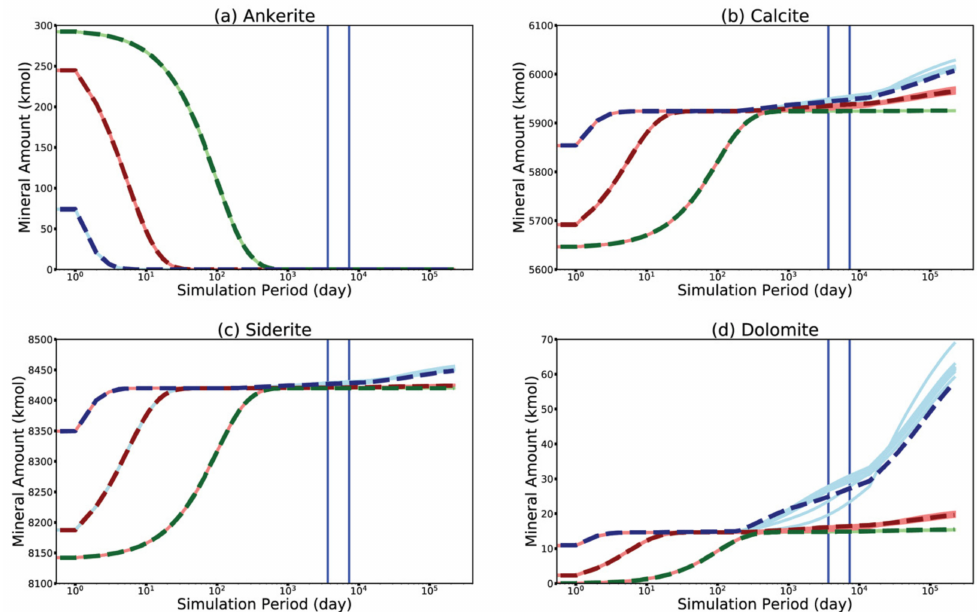
Figure 4. Predicted total mineral amount in the simplified model for ( a ) ankerite, ( b ) calcite, ( c ) siderite, and ( d ) dolomite. Light green, light red, and light blue indicate low, mid, and high RSA of the particular mineral in each subplot; dashed lines in dark green, dark red, and dark blue indicate Case#86, Case #85, and Case #87, respectively; two vertical lines denote the end of 10 years and the end of 20